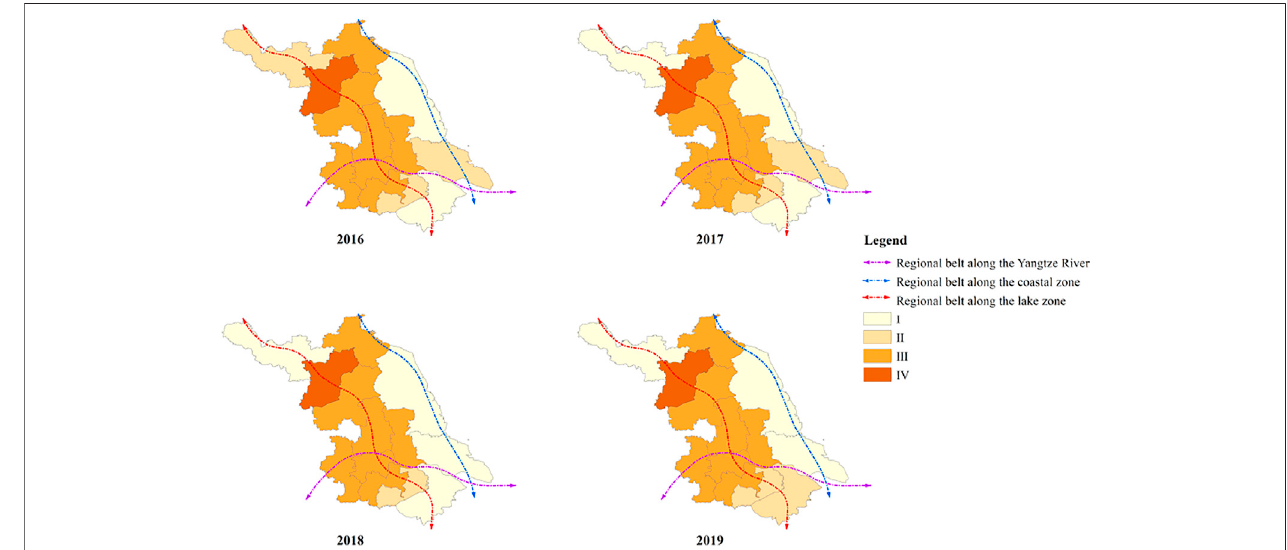
FIGURE 4 | Spatial evolution of SADL in jiangsu province from 2016 to 2019.